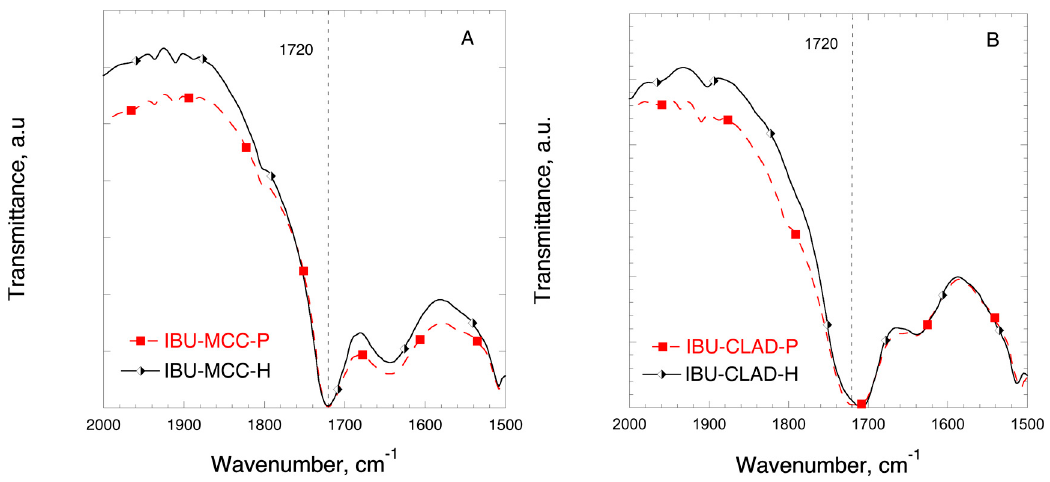
Figure 5 . FTIR profiles of ( A ) IBU-MCC and ( B ) IBU-CLAD 10% w / w mixtures. The symbols are only guide for the eye.